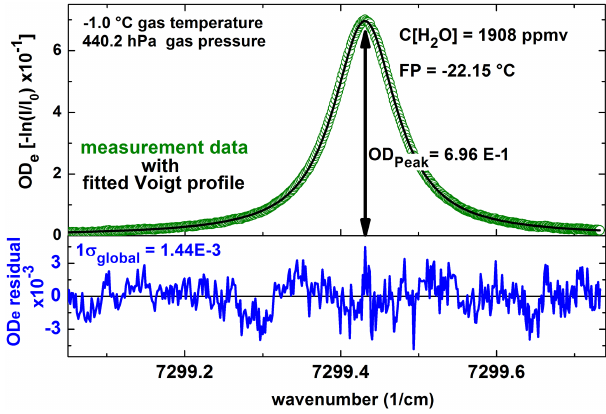
Figure 7. Typical, pre-processed, in-flight line profile measurement after baseline-, offset- and transmission correction. The DFB diode laser scans across the H 2 O transition as shown with 240Hz repeti- tion rate; 50 individual raw scans are pre-averaged and the resulting average scan is then fitted, resulting in 210ms time resolution. The global residual variance 1 σ global of the fit is defined as standard de- viation of the residual over the shown entire fit range. It must be kept in mind that the gas flow is passing through the open-path cell at approximately 900kmh − 1 (see text for more